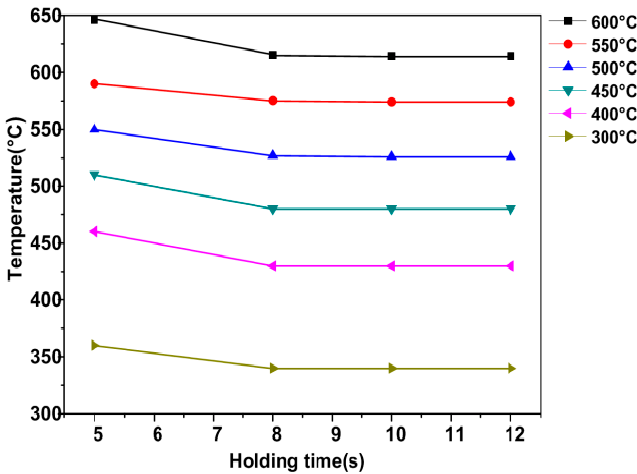
Figure 3. Predicted temperature distribution with a different holding time of ( a ) 5 s, ( b ) 8 s, ( c ) 10 s, and ( d ) 12 s.